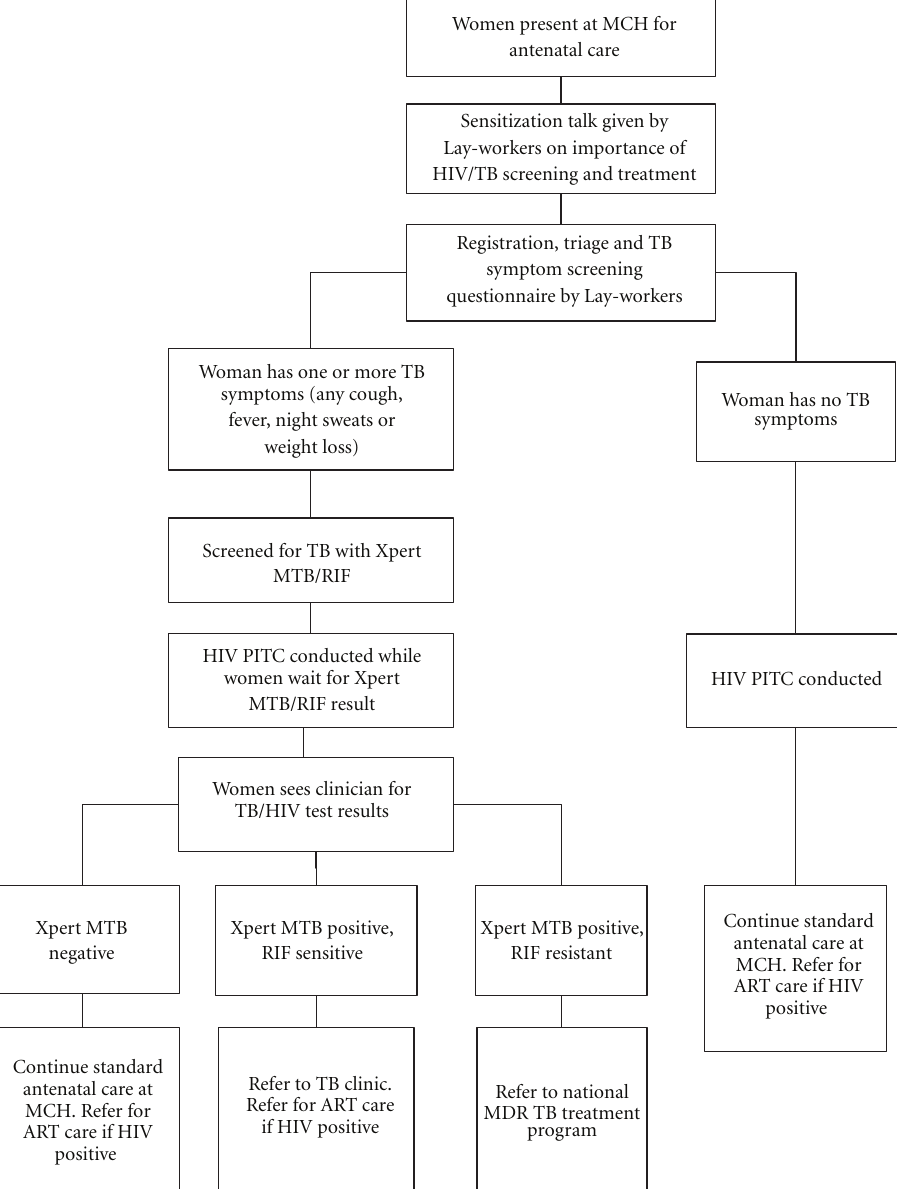
Figure 1: Proposed model for same-day TB screening and diagnosis of pregnant women at antenatal care using Xpert MTB/RIF ( ∗ MCH: Maternal Child Healthcare Clinic; (M)TB: (Mycobacterium) Tuberculosis; RIF: Rifampicin; PITC: Provider Initiated Testing and Counseling; ART: Antiretroviral therapy; MDR: Multidrug